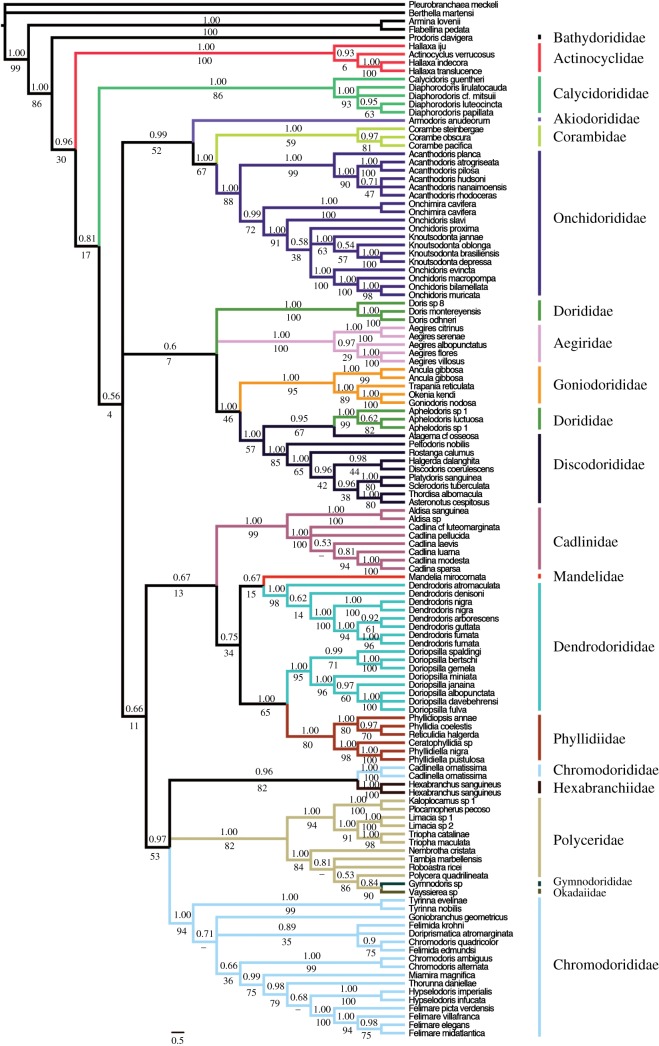
Phylogenetic estimate from MAFFT Alignment. Topology represents Bayesian estimate, with posterior probabilities (pp) and non-parametric bootstrap (bs) support values depicted above and below each branch, respectively. Relationships that were not recovered by ML analysis are represented by dashes. Branches are coloured based on family designations and represented on the exterior of the phylogeny.